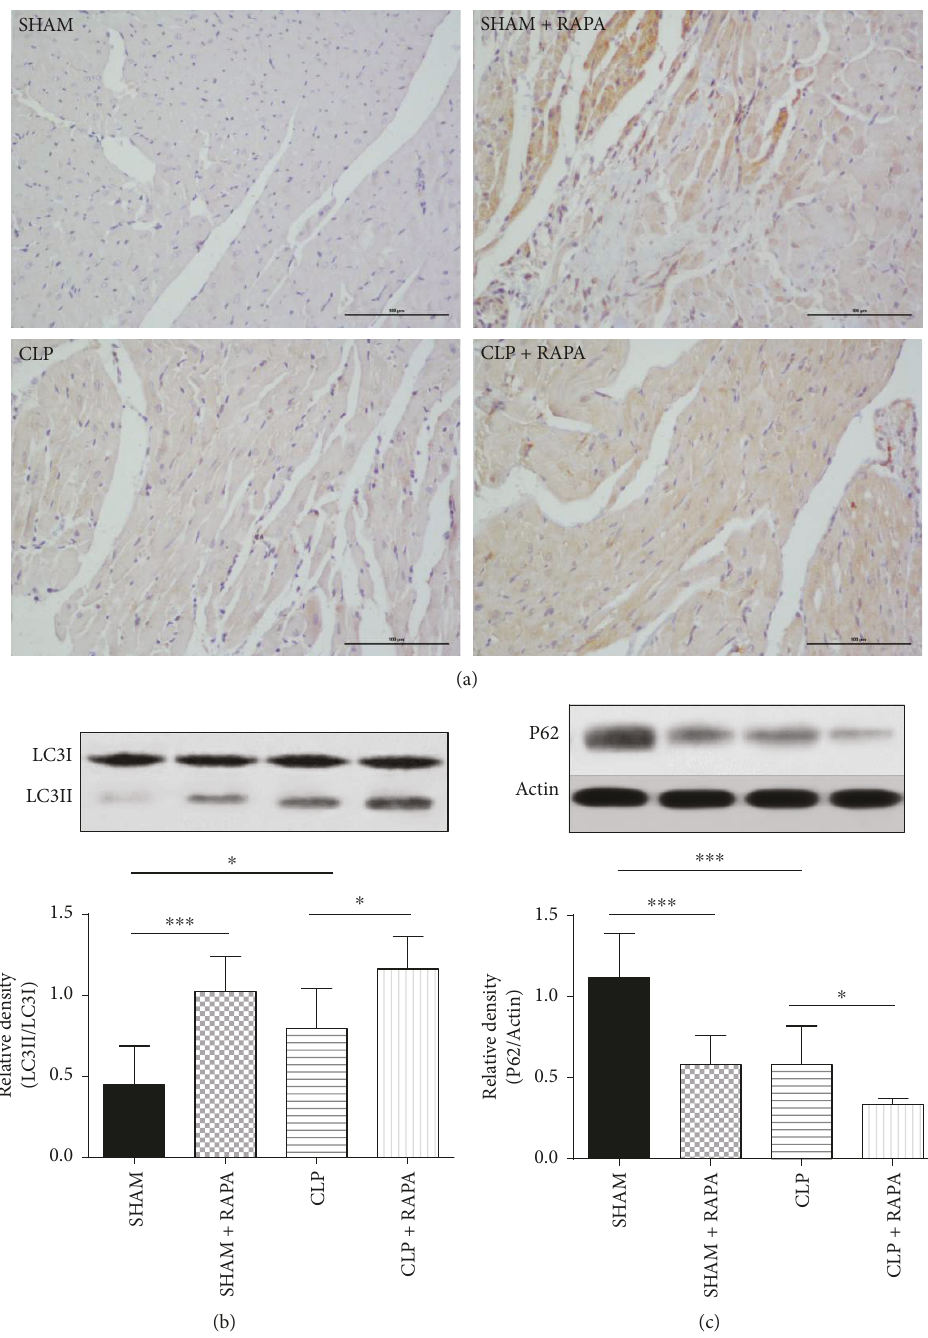
Figure 5: E ff ects of rapamycin on LC3-II and P62 expression in the left ventricle 18 h after CLP. (a) The left ventricle sections stained with an anti-LC3 antibody. Magni fi cation, × 200. Bar, 100 μ m. (b, c) LC3II and p62 expression in the left ventricle. The left ventricle was harvested at 18h after CLP, and LC3II and P62 protein levels were quanti fi ed by western blotting. Mean ± SD, six rats per group, ∗ p < 0 05 ; ∗∗∗ p < 0 001